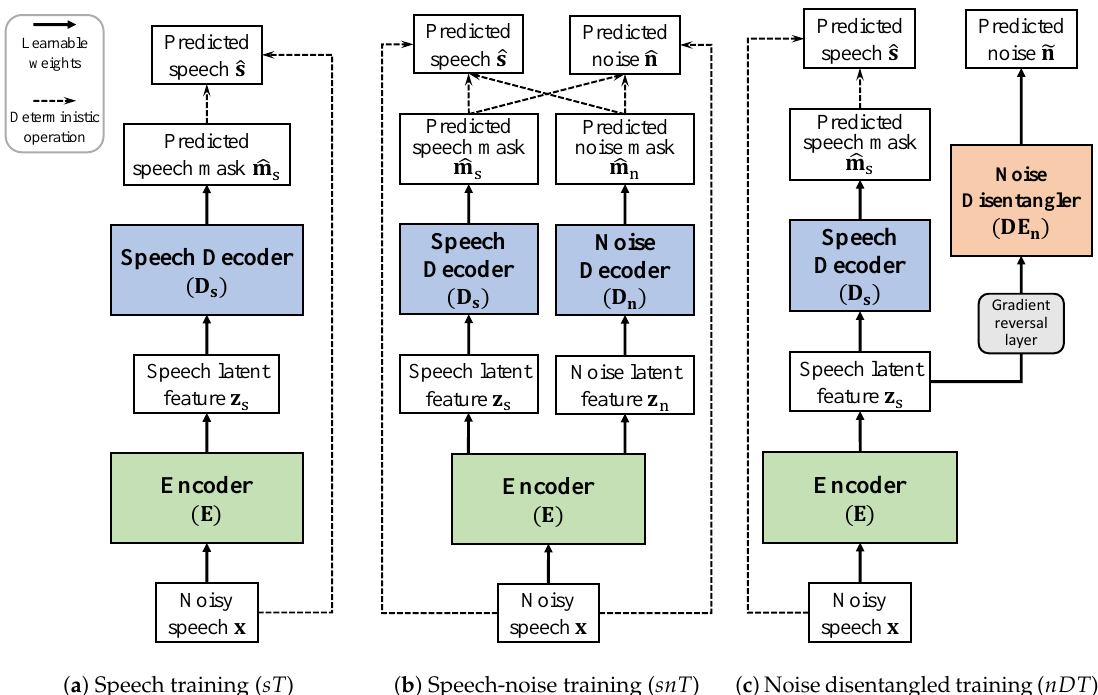
Figure 3. The architectures of the baseline